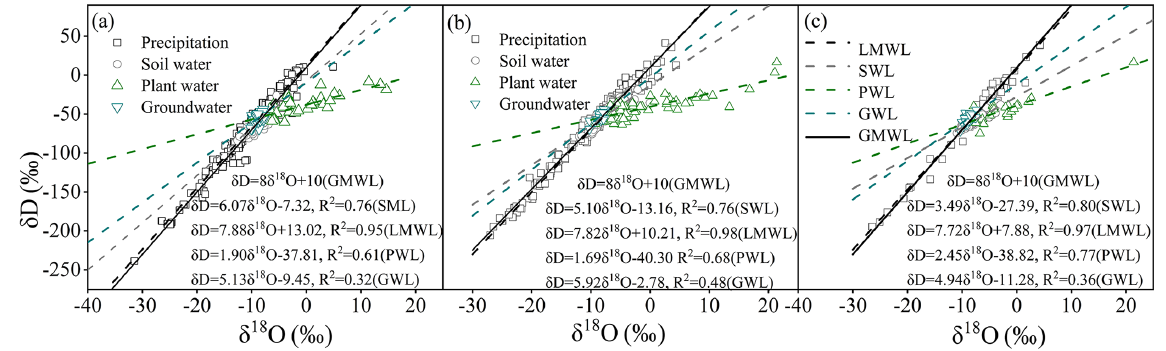
Figure 3. Relationship of stable isotopes in different water bodies in alpine meadow (a) , forest (b) , and arid foothills (c) . Table 2. Comparison of stable isotopes of water in different vegetation